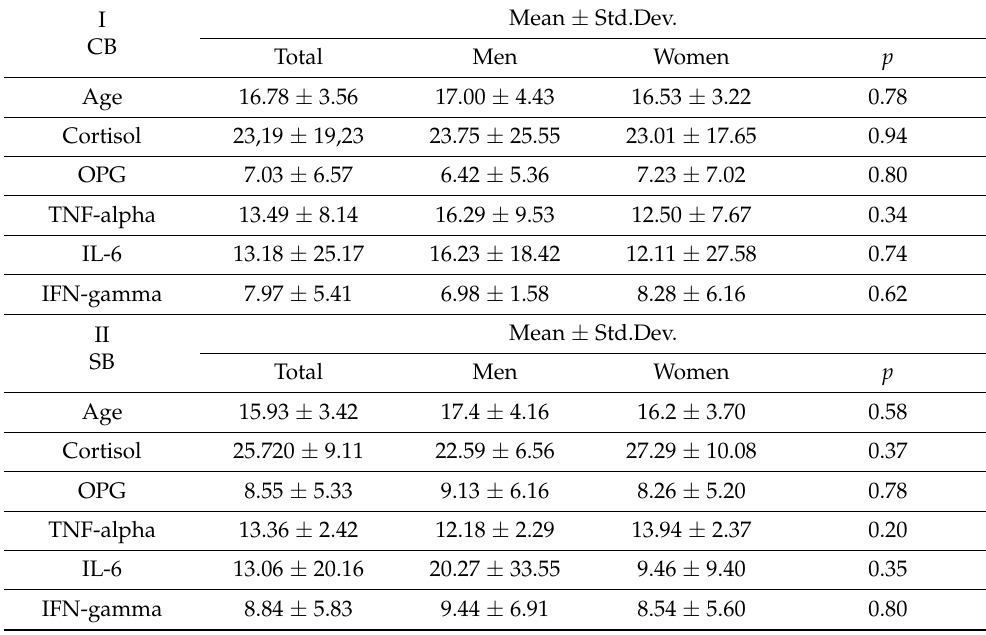
Table 1. The baseline characteristics (mean ± std.dev.) of the studied traits in various groups according to gender: I, conventional brackets (CB); II, self-ligating brackets (SB).